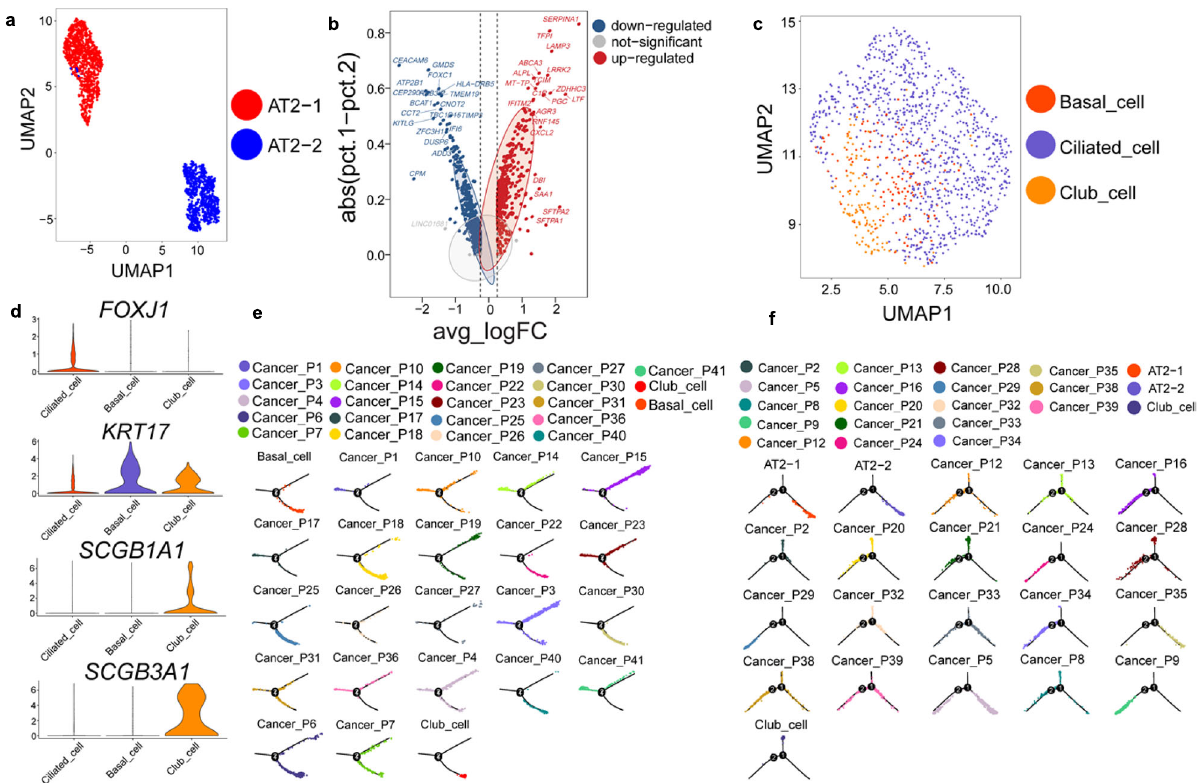
Fig. 3 Phenotypes of lung epithelial cells and their evolutionary trajectory into cancer cells. a UMAP projection of alveolar cells. Alveolar cells could be further divided into two clusters, both of which are AT2 cells. They were denoted as AT2-1 and AT2-2. b Volcano plot of differentially expressed genes between AT2-1 and AT2-2 cells. Difference between percentage of cells expressed in two clusters was plotted against log fold change of average expressions. c UMAP visualization of epithelial cell subtypes. Epithelial cells could be further annotated into basal cells, club cells, and ciliated cells. d Heatmap of canonical marker genes of epithelial lung subtypes. e Developmental trajectories of AT2 cells, club cells, and LUAD tumor cells. Normal cells were shown as a whole for each type, and cancer cells were shown separately for each patient. f Developmental trajectories of basal cells, club cells, and LUSC tumor